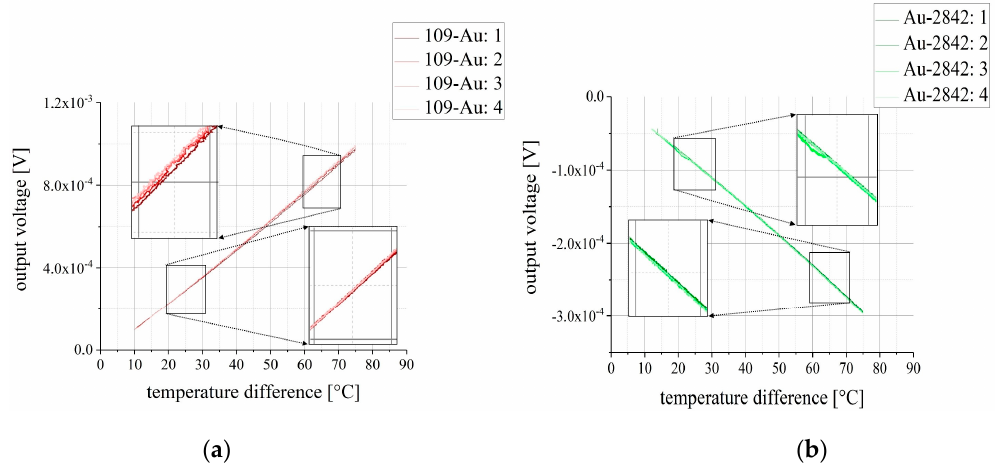
Figure 3. ( a ) The output voltage of the 109-Au thermocouple as a function of temperature difference between junction an connection for four measurement cycles; ( b ) The output voltage of the Au-2842 thermocouple as a function of temperature